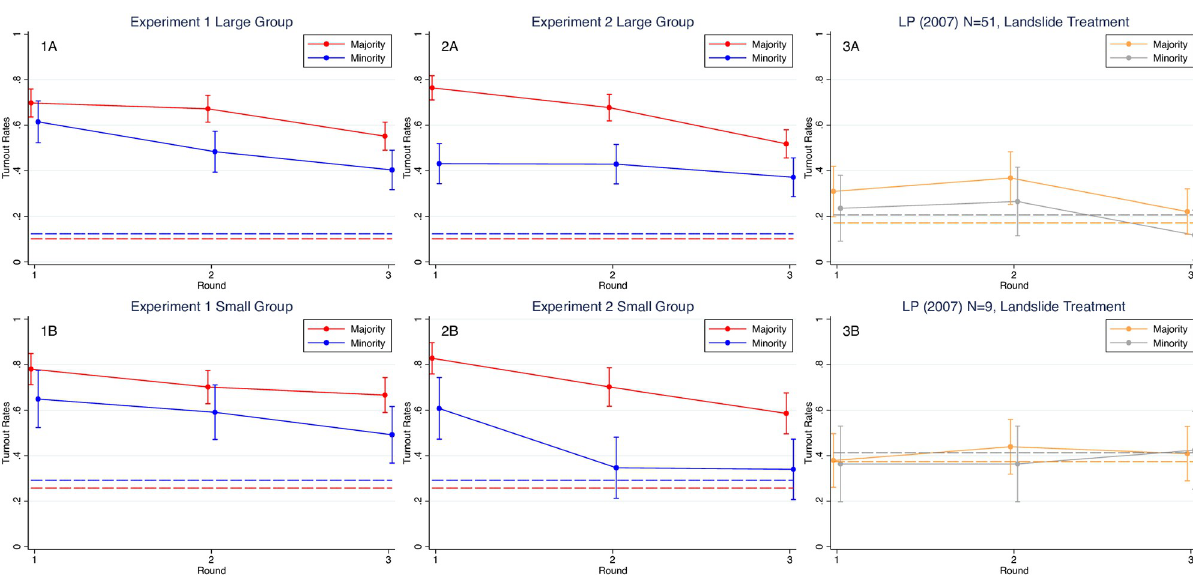
Fig 2. Majority and minority team turnout rates under different electorate sizes. (1A and 1B) The turnout rates for large and small groups from Experiment 1. (2A and 2B) The turnout rates for large and small groups from Experiment 2. (3A and 3B) The turnout rates in round 1 to round 3 for large ( N = 51) and small ( N = 9) treatments from [14]. The red (orange) and blue (gray) curves are the turnout rates for the majority and minority teams (with 95% CI), respectively. The dotted lines are the theoretical predictions of the majority and minority turnout